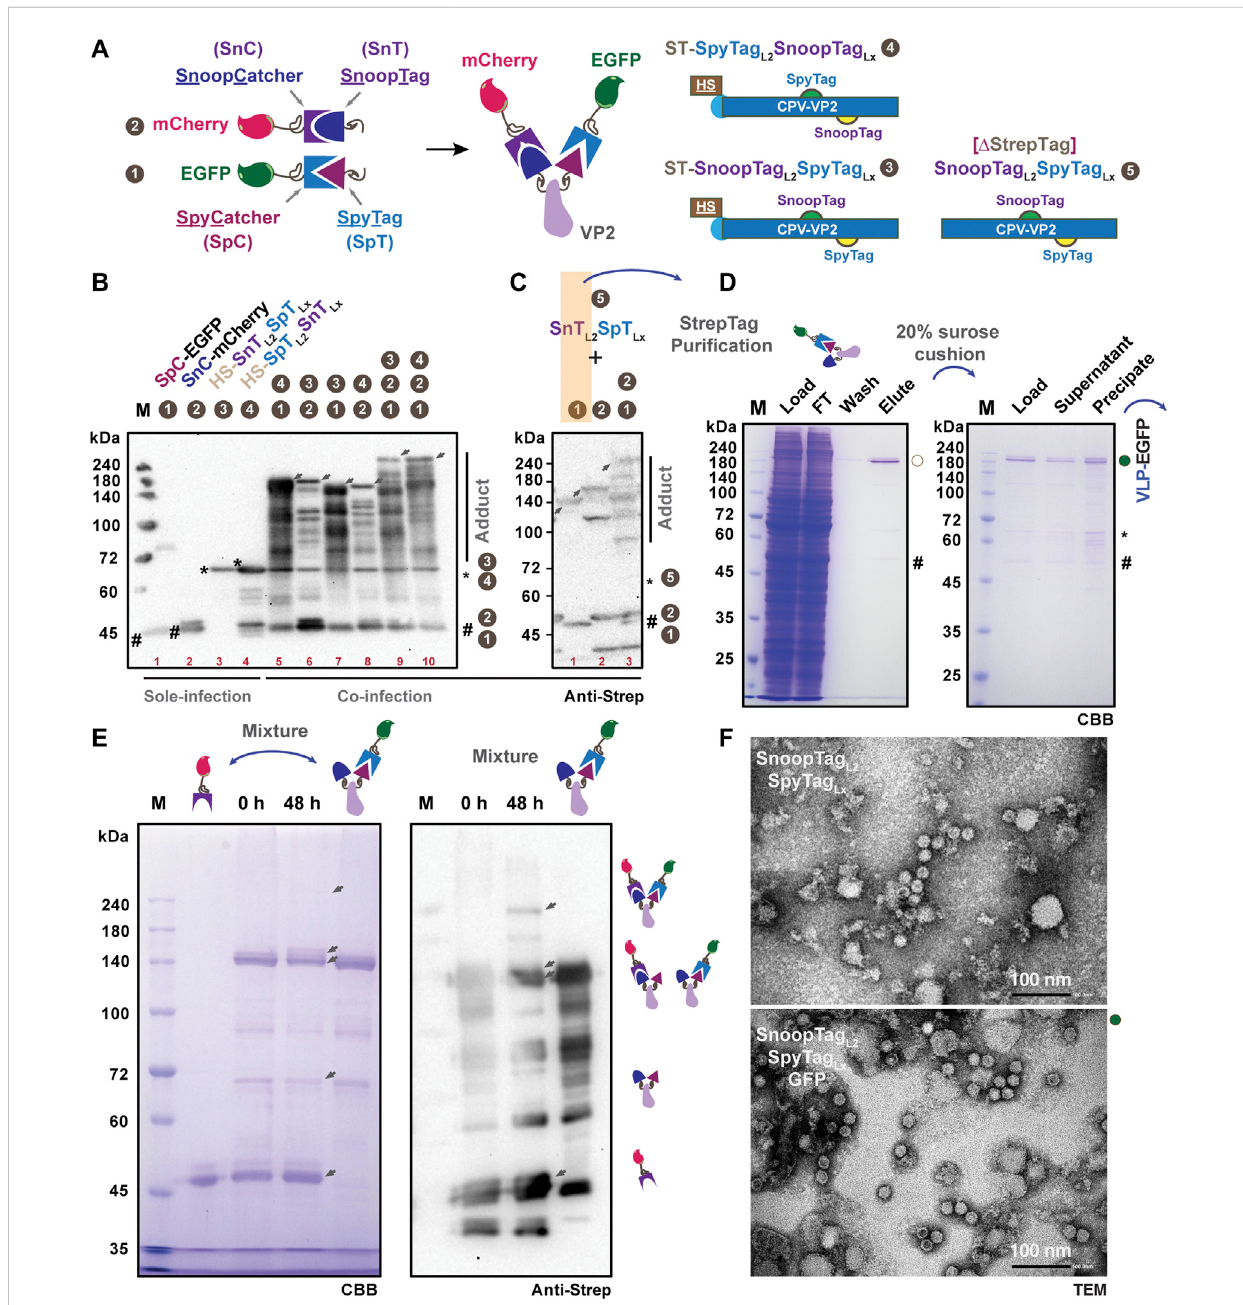
FIGURE 4 Design and veri fi cation of multiple protein display in SpT- and SnT-inserted VP2-derived VLPs. Schematic representation of the speci fi c covalent binding between SpT and SpC, SnT and SnC, respectively. Five constructs, SpC-EGFP 1), SnC-mCherry 2), VP2-SnT L2 SpT Lx 3), VP2-SpT L2 SnT Lx 4), VP2- SnT L2 SpT Lx ( Δ StrepTag,5) weredesigned inthisstudy for multiple proteindisplay (A) . Expression veri fi cationof thoseconstructs,either insole, double, or triple infections, was performed in cultured Bm5 cells (B) . Upon co-infection, the gradient increased adducts were shown as indicated by arrows. The expression and binding ef fi ciency in Bm5 cells among VP2-SnT L2 SpT Lx ( Δ StrepTag, 5), SpC-EGFP (1), and SnC-mCherry were further validated by western blot using the anti-Strep antibody (C) . The puri fi cation from co-infection of VP2-SnT L2 SpT Lx ( Δ StrepTag, 5) and SpC-EGFP (1) in silkworm larvae was conducted, and the elution from in vivo binding products was further subjected to ultracentrifugation through a 20% sucrose cushion. The EGFP- displayed VLP (VLP-EGFP) was presented in precipitation (D) . In vitro binding between puri fi ed SnC-mCherry and (SnT L2 )(SpT Lx -SpC-EGFP)] (VLP-EGFP, (D) wasassayedfor48 h,andtheresultsweredemonstratedinSDS-PAGE (E) ,leftpanel)andwesternblot(anti-Strep, (E) ,rightpanel).TheTEMimagesfor VLP validation are in (F) (upper panel: SnT L2 SpT Lx ; lower panel: SnT L2 SpT Lx :GFP). Scale bar: 100